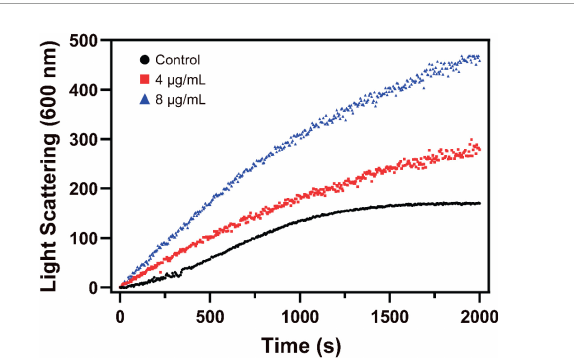
FIGURE6 The effect of S2303 on Staphylococcus aureus FtsZ assembly in vitro . Polymerization of SaFtsZ (11 µ M) was initiated by 1 mM GTP and the assembly of FtsZ in the absence [1% Dimethyl sulfoxide (DMSO), dark] or presence of 4 µ g/mL (red) and 8 µ g/mL (blue) S2303 was monitored by 90 ◦ angle light scattering. Appropriate blanks were subtracted from all the traces; the experiment was repeated in